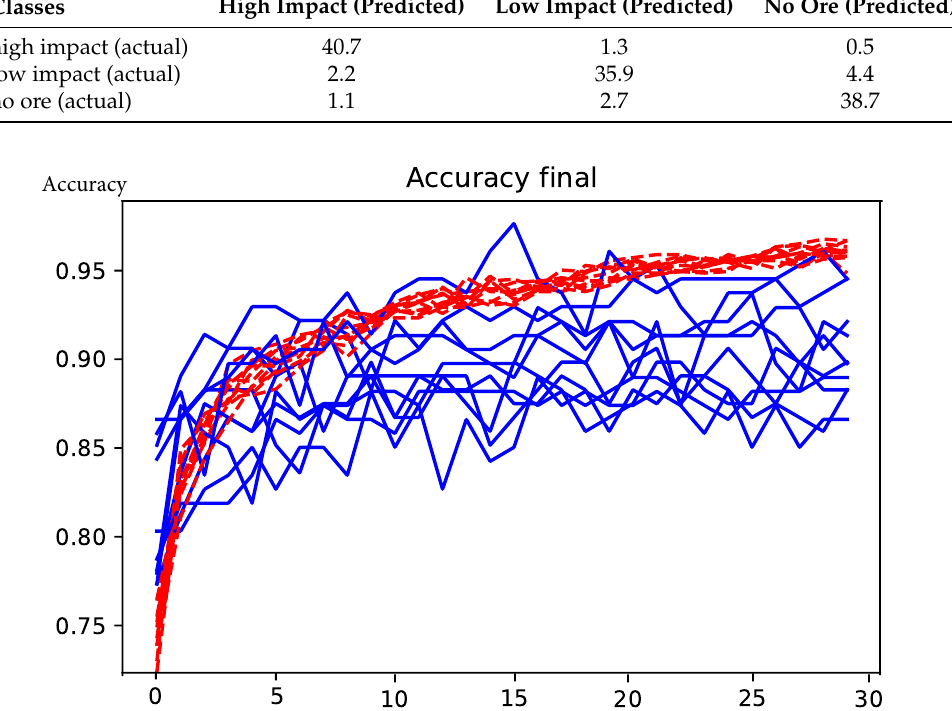
Figure 8. Evolution of accuracy for environmental impact prediction over 30 training epochs and 10-fold cross validation. Red lines indicate training accuracy and blue lines indicate validation